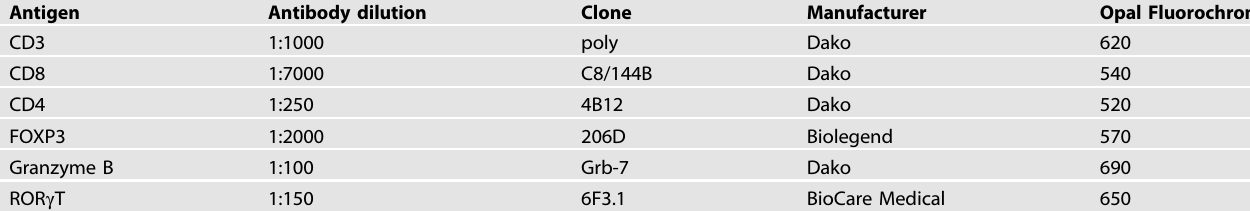
Table 1. Target antigens, antibody clones, and dilutions for markers used.